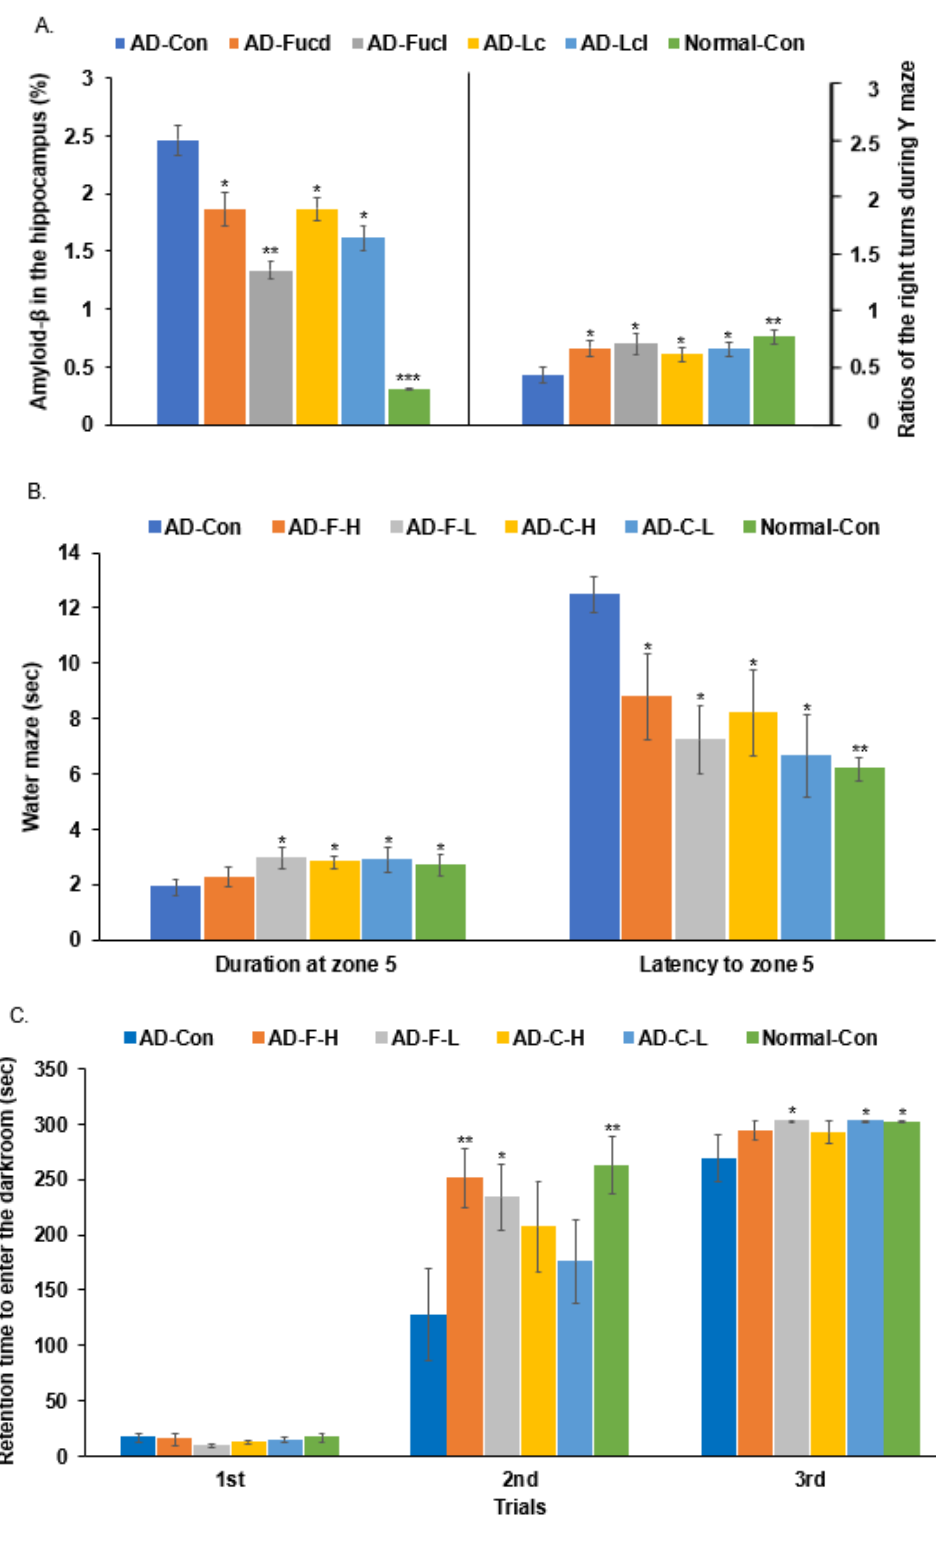
Figure 2. Memory deficits in rats after hippocampal amyloid- β infusion. ( A ) Percentage of correct alternations to total rotations in the Y maze test. ( B ) The frequencies of visiting zone 5 where the platform was located, time spent in zone 5, and time spent finding the target area (zone 5) in the third trial in the water maze test. ( C ) Latency time to enter the darkened room in the passive avoidance test in two training trials every 8 h and the last trial 24 h later. The bars and error bars represent